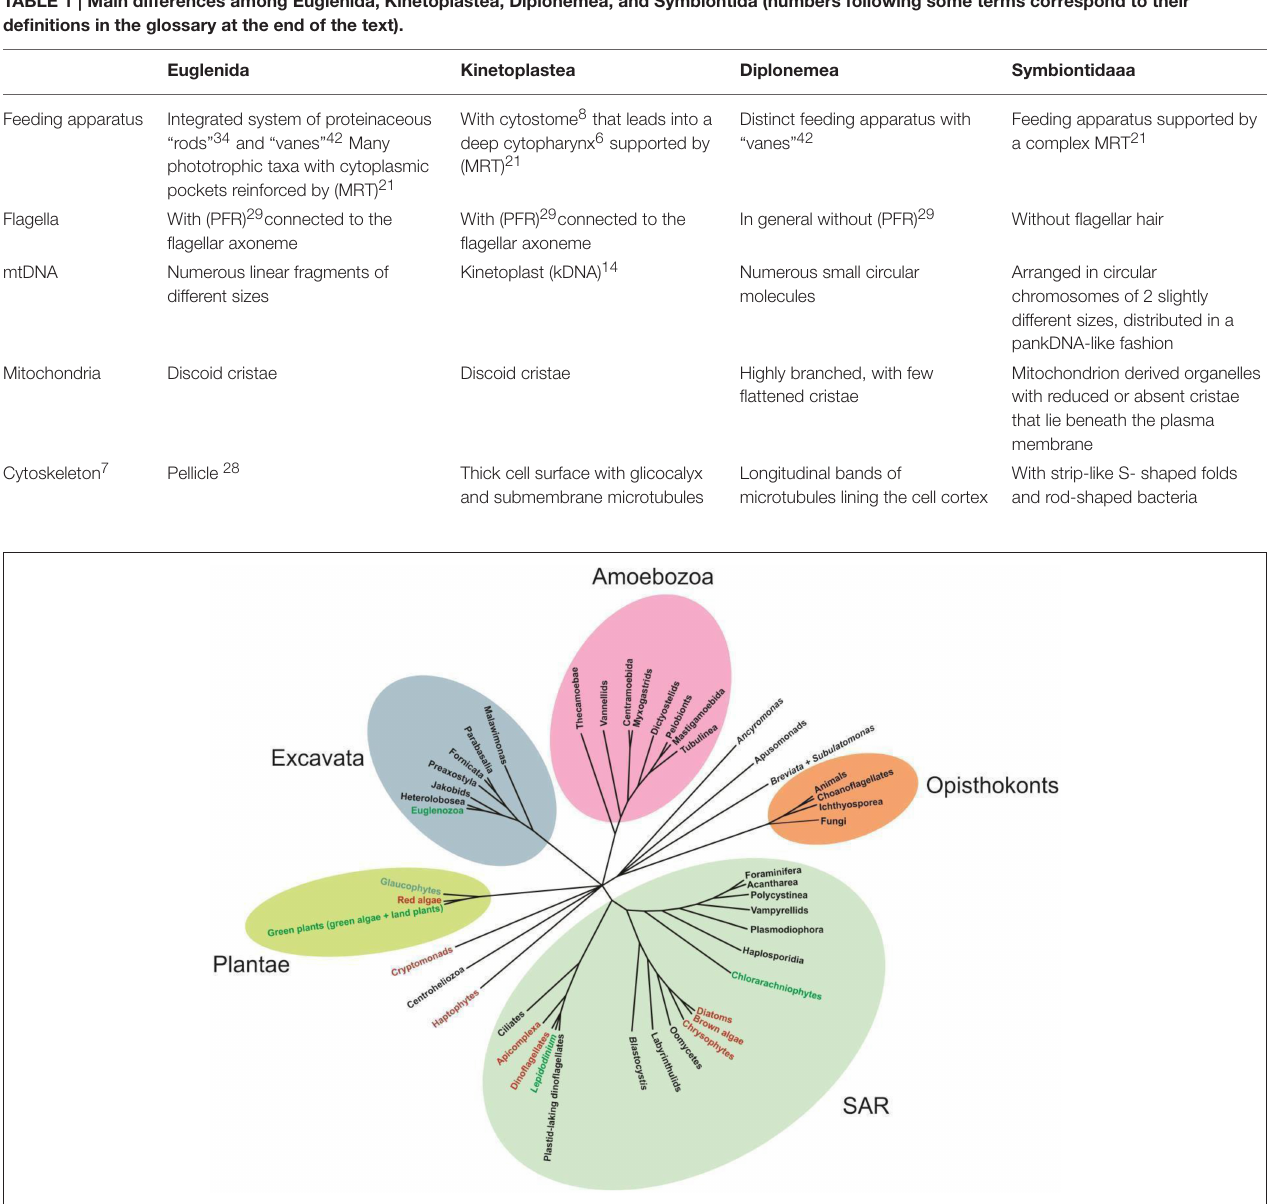
FIGURE 1 | Unrooted phylogenetic tree showing the relationships among representatives of major eukaryote lineages, based on a variety of molecular and morphological data. Green and red text indicates green and red algae derived chloroplast lineages, respectively (Adapted from Katz,